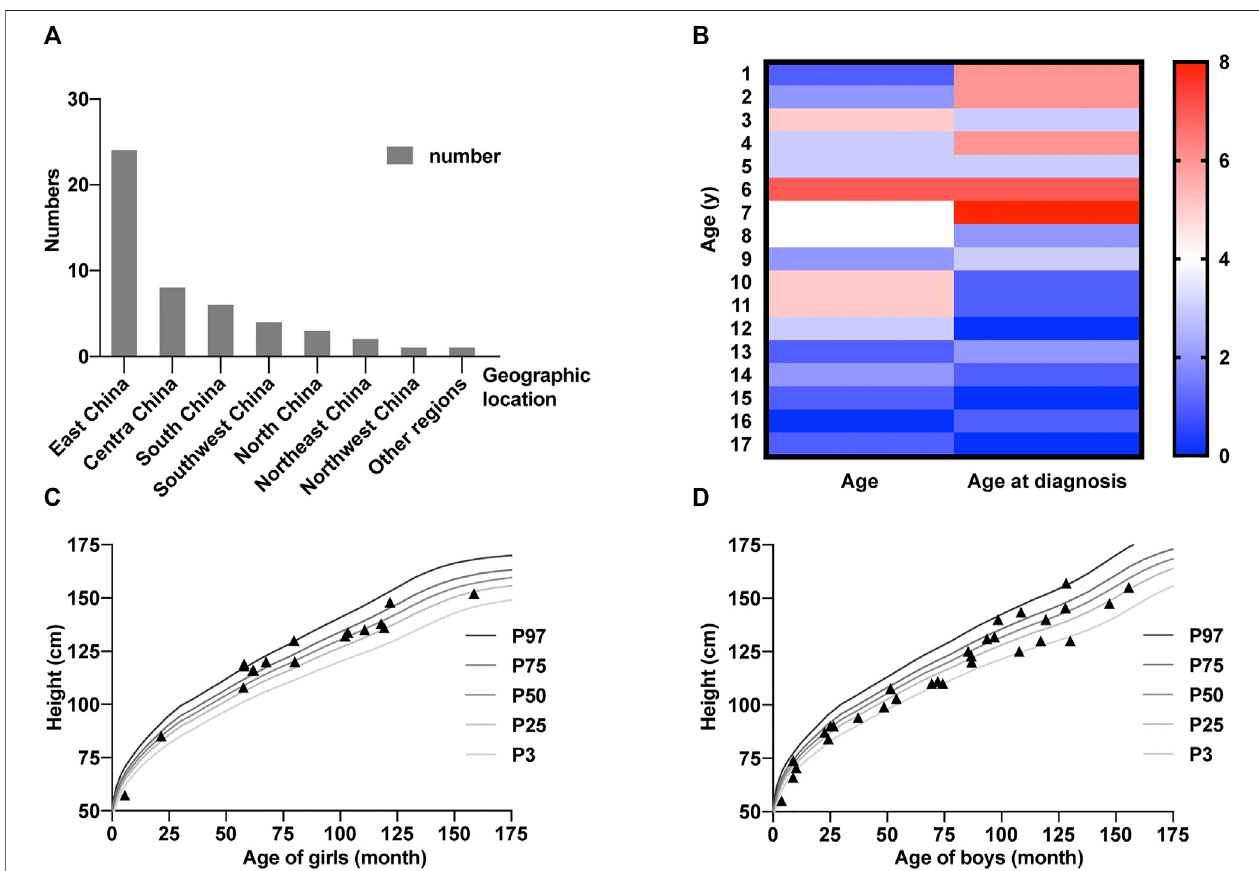
FIGURE 1 | Basic characters of the Chinese cohort. (A) Numbers of patients in different areas of China. (B) Heatmap representing age distribution of 50 ALMS patients. The columns represent the number of patients with ages at present and at diagnosis. The color bar shows the range of numbers. (C,D) Height of girls (C) and boys (D) included in this study. The standard child growth curves are extracted from Li et al. (2009).